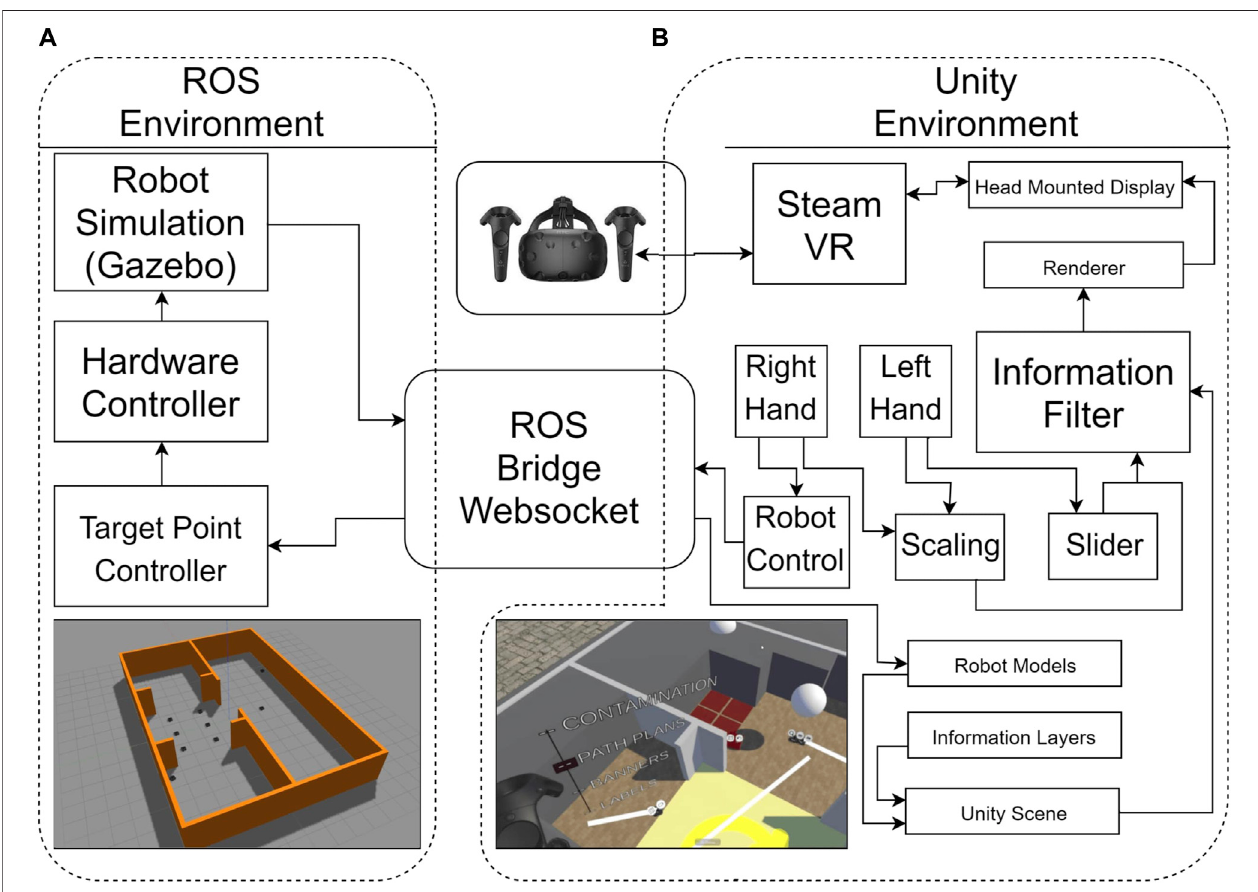
FIGURE 2 | An overview of the setup that contains the ROS simulation (Ubuntu, A ) and the Unity VR program (Windows, B ). The communication between the computers used the Rosbridge Websocket.